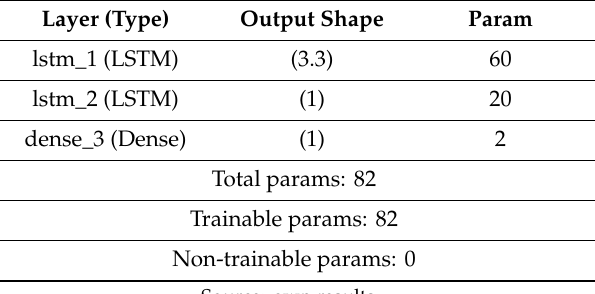
Table 1. Long Short-Term Memory (LSTM) network parameters.